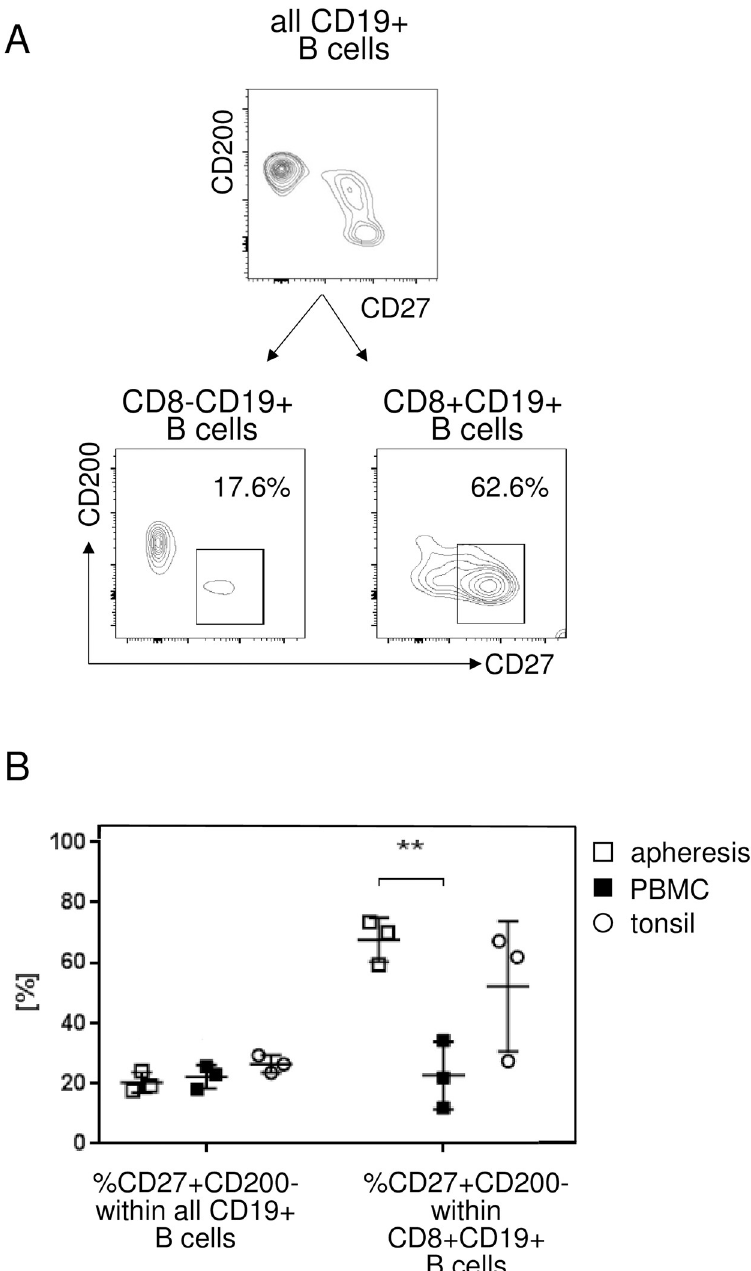
Fig 4. Distribution of B cell subsets in the CD27/CD200 space. (A) In a multicolor FACS analysis, CD19+ B lymphocytes were gated first (top), and these divided then into CD8- (left panel) and CD8+ fractions (right panel). Distribution of these cell subsets as defined by CD27 and CD200 expression are shown as probability plots. One representative apheresis material out of four independent donors tested shown. (B) Proportion of CD27+CD200- cells within CD19+ B cells and the proportion of CD8+CD19+ cells within the CD19+CD27+CD200- pool are shown from apheresis material (open squares), normal peripheral blood (black squares), and from tonsils (open circles). Average and high / low ranges are indicated by lines. ( �� ) indicates p <